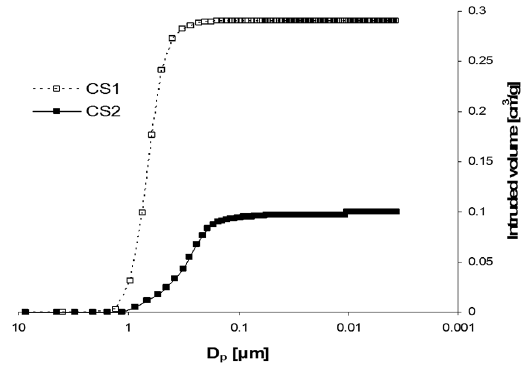
Figure 2: Mercury intrusion curves. The lowest pore sizes correspond to the maximum pressure.